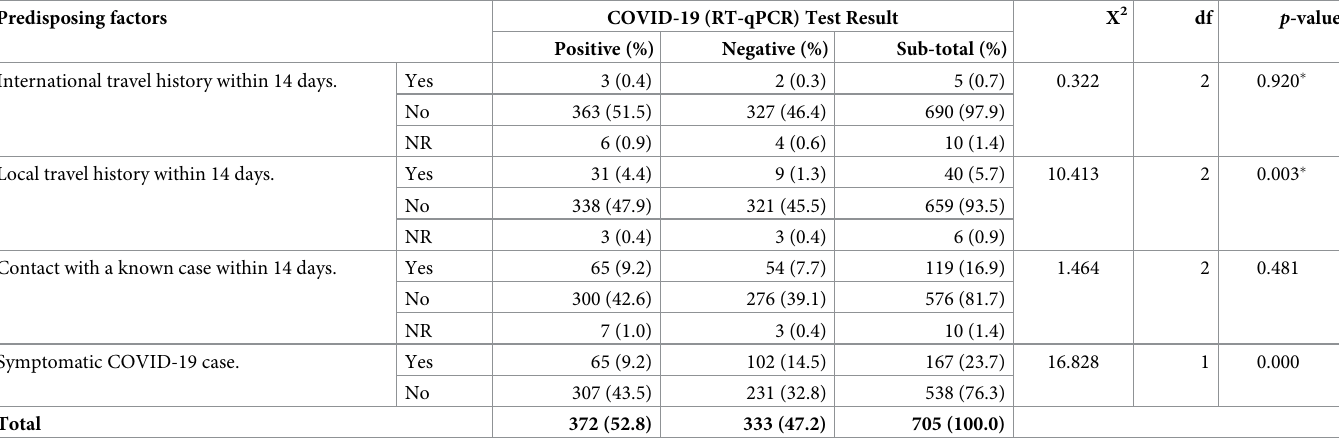
Symptomatic COVID-19 case. Total NR: no response. Percentages (%) represent proportions of the total within respective category. � Fishers exact